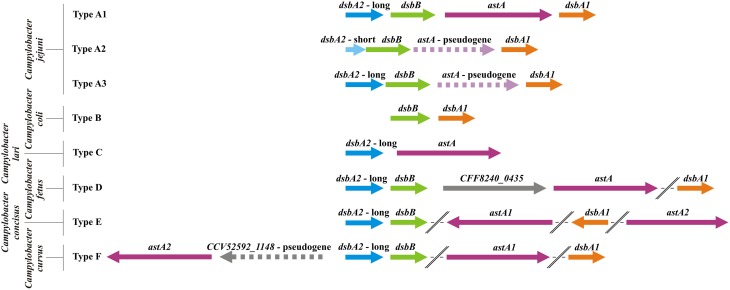
Physical map presenting the genomic location of the
Campylobacter
Dsb oxidative pathway genes [dsbA1
(orange),
dsbA2
(blue),
dsbB
(green), and
astA
genes (purple)]. The astA gene was also included as it is a part of the same transcriptional unit with dsbA2 and dsbB, and its product is a substrate for DsbA2. Type A includes C. jejuni strains (A1: C. jejuni
subsp.
jejuni
81-176, 81116, ICDCCJ07001, MTVDSCj20, and C. jejuni 4031; A2: C. jejuni
subsp.
jejuni
NCTC 11168 = ATCC 700819, 00-2425, 00-2426, 00-2538, 00-2544, IA3902, NCTC 11168-BN148, PT14, R14, and C. jejuni 32488; A3: C. jejuni
subsp.
jejuni
S3 and M1, C. jejuni RM1221, C. jejuni subsp. doylei 269.97). Type B includes strains of C. coli species (C. coli
RM5611, 15-537360, CVM N29710, RM1875 and RM4661). Type C is represented by one C. lari strain (C. lari
RM2100). Type D includes three members of C. fetus species (C. fetus
subsp.
fetus
82-40, 04/554 and C. fetus subsp. testudinum 03-427). Type E is represented by one C. concisus strain (C. concisus
13826) and type F by one strain of C. curvus (C. curvus
525.92). The dsbA1 and astA genes of C. concisus, C. curvus, and C. fetus, strains are located on the chromosome apart from dsbA2dsbB genes. Genes and intergenic regions are drawn to scale (based on underlined strains). Pseudogenes or fragmented genes are marked with dashed lines.